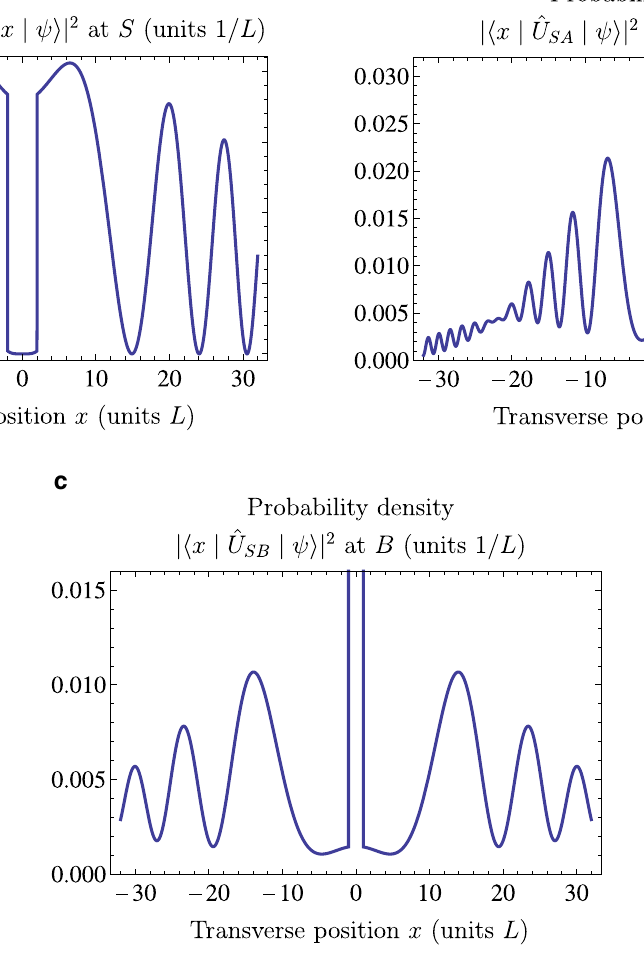
Figure 3. Probability densities of particle detections for the optimized state | ψ � with a quantum overlap of � A | B � = 0.150 . ( a ) The probability density at S , where the screen blocks out the line-of-sight positions at | x | ≤ 2 L . Quantum interferences enhancing the probabilities of hitting the targets A and B surround the blocked region. ( b ) The probability density at the target A . The central peak has a width of L and a height of 0.537/ L . The interference pattern surrounding the central peak originates from the destructive interference between | B � and | S � . The total probability of missing the target at A is 46.3%. ( c ) The probability density at the target B . The pattern is the same as the one at A , but it is exactly twice as wide and half as dense. The central peak has a width of 2 L and a height of 0.269/ L . Even if all of the 46.3% of photons that miss target A were hitting target B instead, at least 7.4% of the photons must be hitting target A as